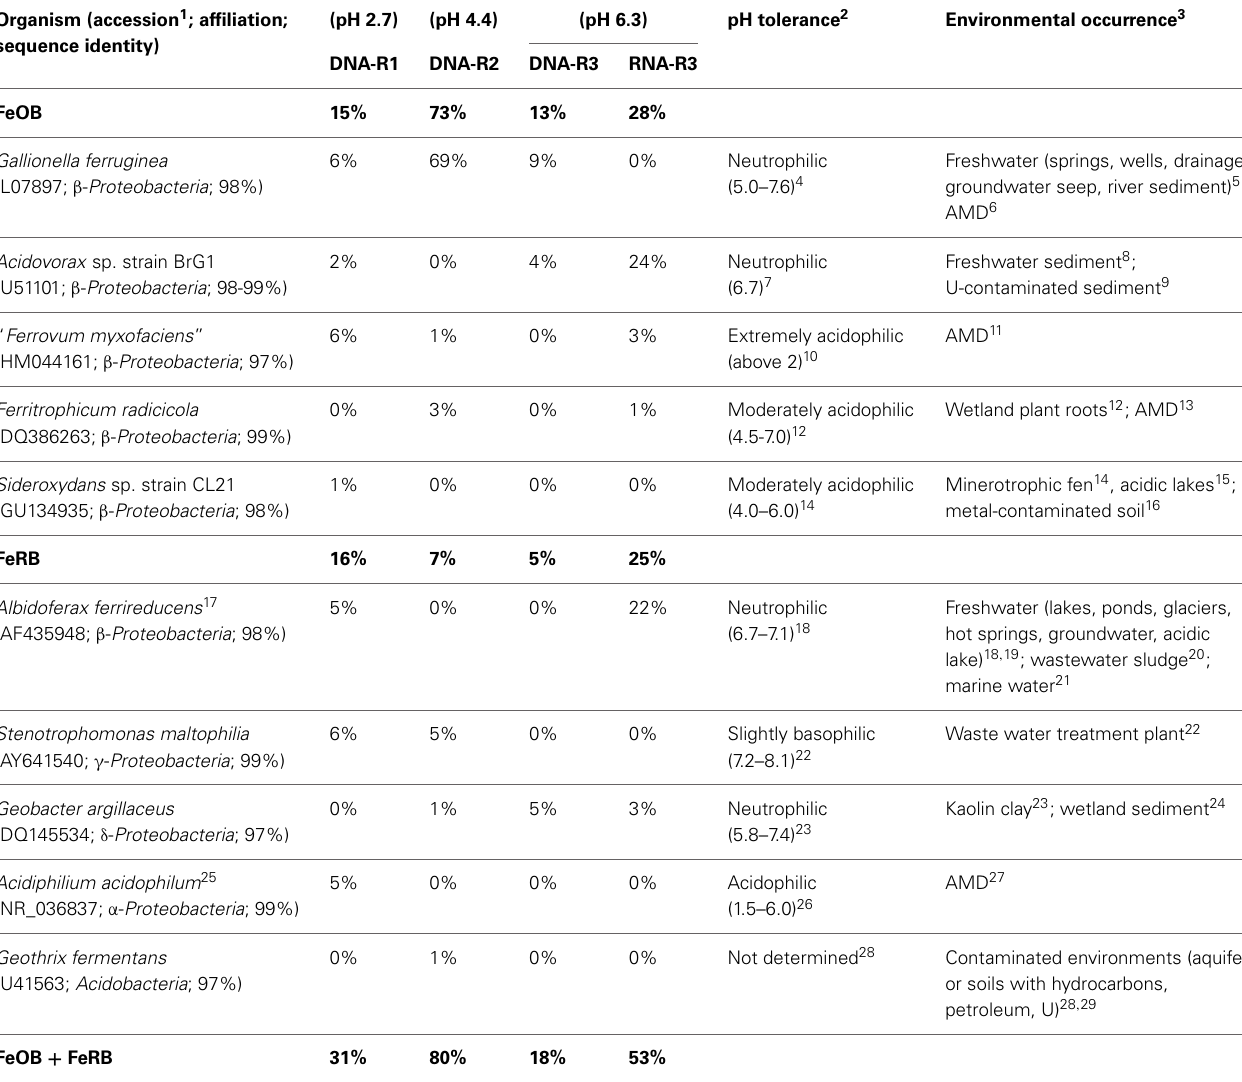
Table 1 | Fractions of clone sequences with ≥ 97% sequence identity to reported FeOB or FeRB in 16S rRNA gene and 16S rRNA clone libraries constructed from creek sediment of sites R1 (DNA-R1), R2 (DNA-R2), and R3 (DNA-R3 and RNA-R3), as well as pH tolerance and environmental occurrence of the known